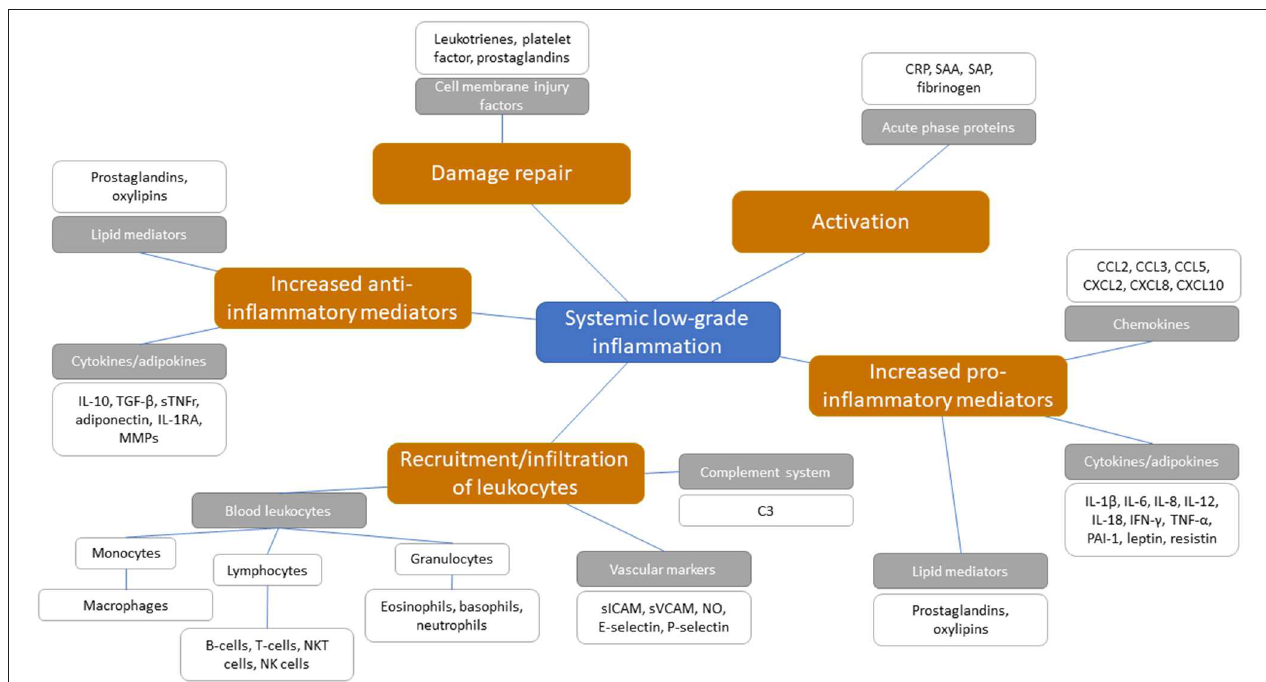
FIGURE 2 | Potential systemic biomarkers categorized following the sequential steps involved in the inflammatory cascade with chronic low-grade inflammation. Orange boxes represent the sequential steps involved in the inflammatory response within chronic low-grade inflammation. Gray boxes represent inflammatory biomarker classes and are categorized under the sequential inflammatory steps. White boxes present the biomarkers as positioned under the inflammatory biomarker classes.